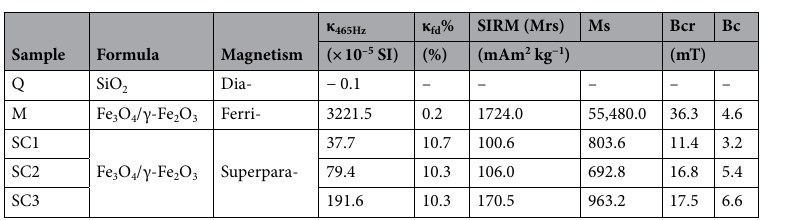
Table 1. Magnetic parameters (κ 465Hz —volume magnetic susceptibility; κ fd %—percentage frequency- dependent magnetic susceptibility; SIRM (Mrs)—remanent saturation magnetization; Ms—saturation induced magnetization; Bcr—coercivity of remanence; Bc—coercive force) of the tested samples (Q—quartz; M— magnetite/maghemite; SC1-3—soil concretions).